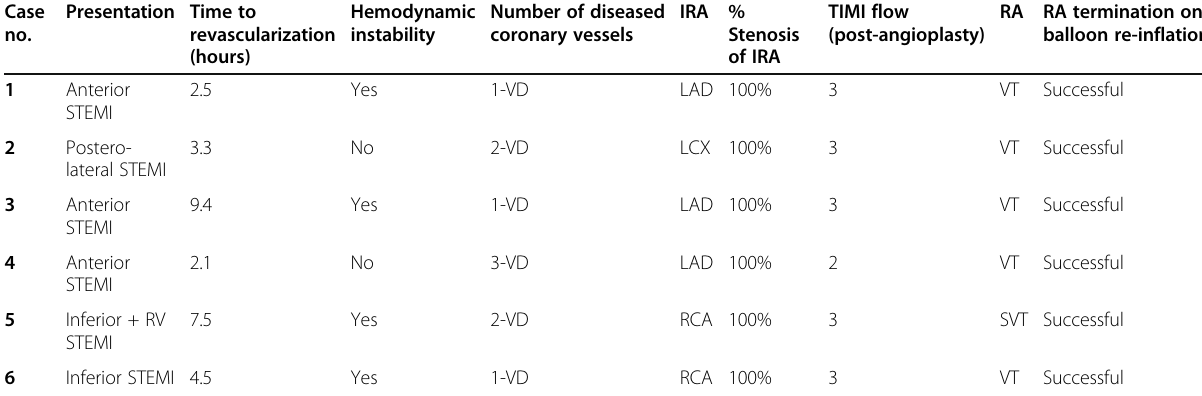
Abbreviations : IRA infarct-related artery, LAD left anterior descending artery, LCX left circumflex artery, RCA right coronary artery, RA reperfusion arrhythmias, RV right ventricular, STEMI ST elevation myocardial infarction, SVT supraventricular tachycardia, VT ventricular